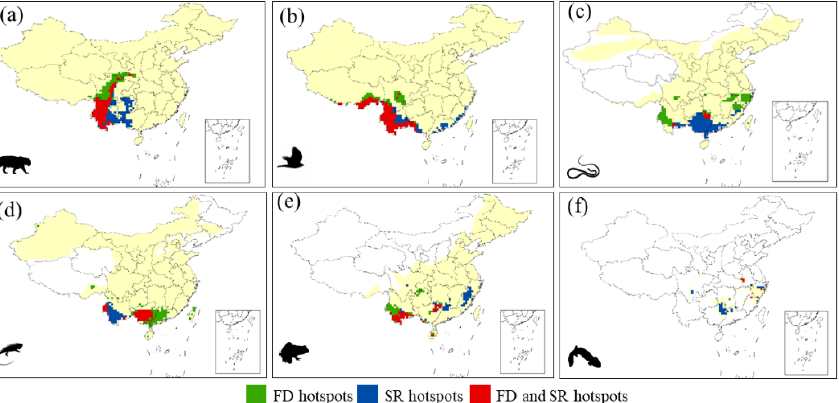
Figure 1. Geographic distributions of functional diversity (FD) hotspots and species richness (SR) hotspots. The green indicates FD hotspots, dark blue indicates SR hotspots and red indicates FD and SR hotspots. ( a ): Mammals; ( b ): Birds; ( c ): Snakes; ( d ): Lizards; ( e ): Anura; ( f ): Caudata. Silhouettes were downloaded from PhyloPic (www.phylopic.org accessed on 14 December 2020). The map content approval number is GS(2019)1822.